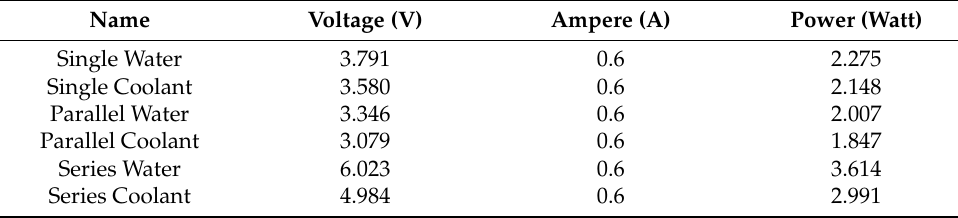
Table 2. Electric power calculation for each